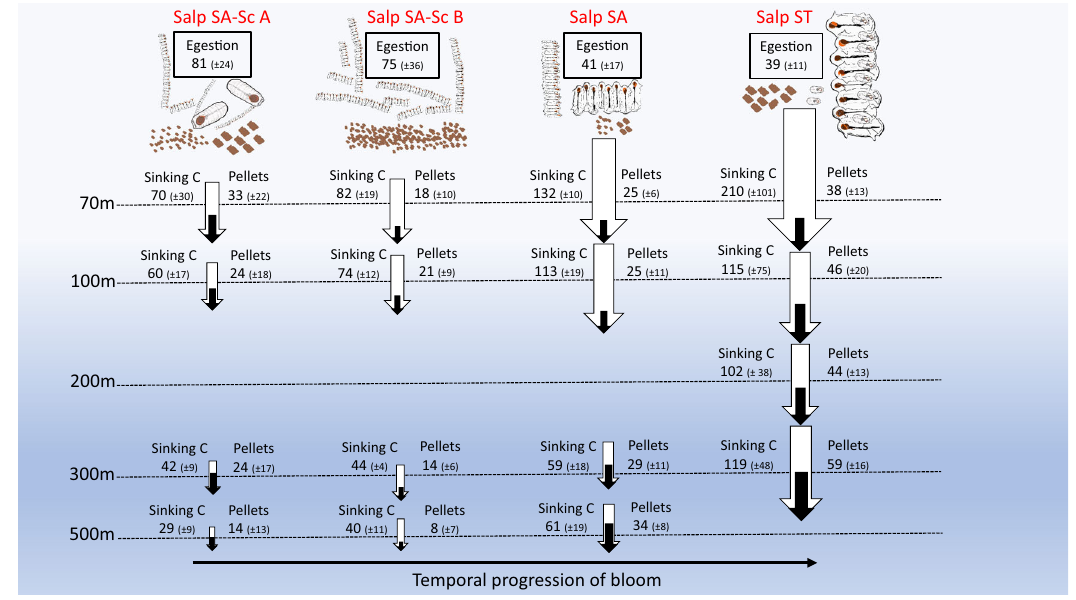
fl ux.Depthhorizonsindicatedbydottedlinesarenotdrawntoscale.Whitearrows arethetotalPOC fl uxateachdepth,blackarrowsinsidethewhitearethemeasured C fl ux of intact salp fecal pellets at each depth (both collected in particle intercept traps). Egestion is the sum for both blastozooids and oozooids in each